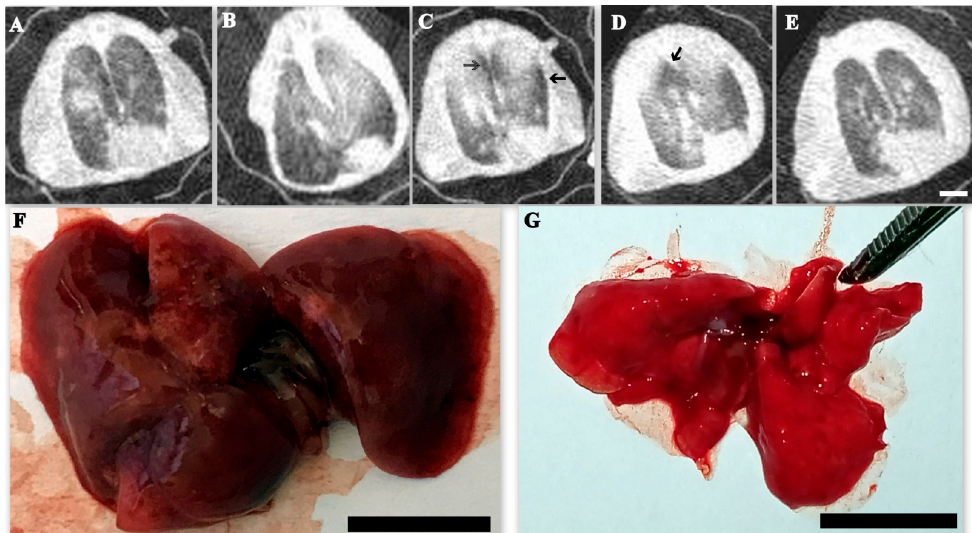
Figure 8. Lung computed tomography and Gross pathology in SARS-CoV-2infected hamsters. ( A ) Local ground-glass opacities with a central, peribronchial distribution in SARS-CoV-2 infected animals (3rd dpi). ( B ) Ground-glass opacities mixed with areas of focal consolidation (4th dpi). ( C ) Local emphysema formation (arrowed) at 5th dpi. ( D ) Massive emphysema formation (arrowed) at 7th dpi ( E ) Scale bar 0.5 cm for (A–E) Recovering at 12th dpi and residual, minimal lung abnormalities ( F ) Lung autopsy (SARS-CoV-2 infected hamsters on 7 dpi), the lungs are enlarged (scale bar 1 cm), flabby consistency. Many local hemorrhages. ( G ) Gross pathology study did not reveal any visible pathology in all studied hamsters since 18th dpi. (scale bar 1 cm).